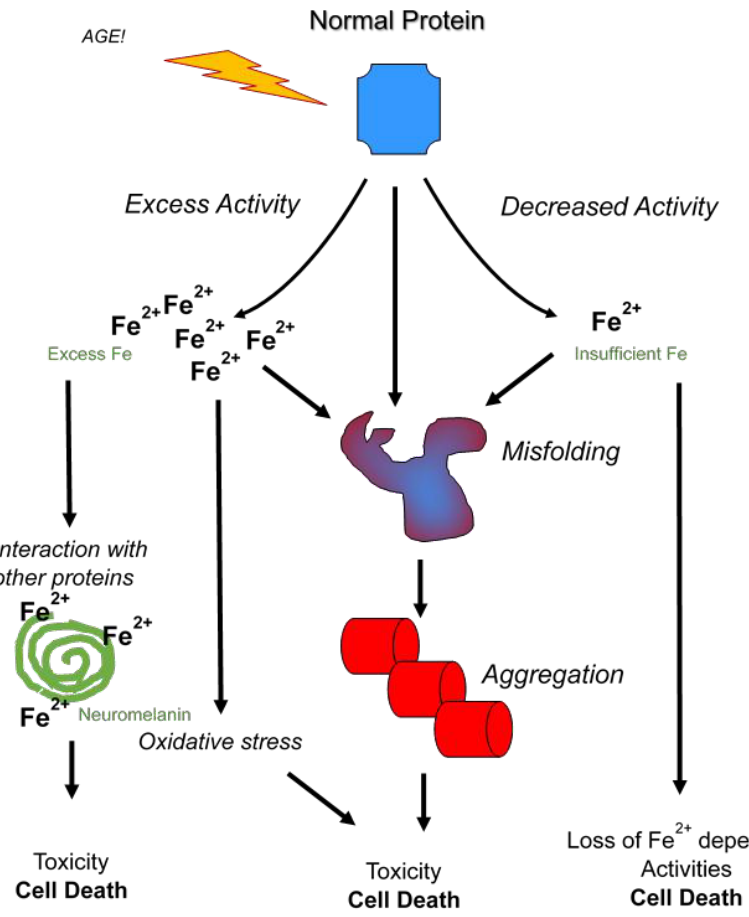
Figure 2. While numerous proteins associated with neurodegeneration may have a role in iron metabolism in the healthy cell, under certain conditions these processes might be disturbed. This diagram represents a summary of the potential changes that can occur during aging which might disturb the way iron is either utilized or its interactions with other proteins. Changes in the protein might result in changes in levels of iron, particularly Fe 2+ . The protein may become overexpressed, resulting in the formation of excess Fe 2+ , or some kind of damage to the protein might result in lost activity and reduced Fe 2+ . Additionally, aging effects might result in the misfolding of the protein, either as a result of an increase or a loss of interaction with iron or simply through another process. Misfolded protein could then aggregate and cause toxic damage to cells. In the case of excess generation of Fe 2+ , there could be abnormal interaction with other proteins such as neuromelanin or the Fe 2+ could result in oxidative stress. In both cases the end result could be the generation of toxic species that lead to cell death. Lastly, in some cases the lack of Fe 2+ might result in a breakdown of essential cellular process necessary for cell